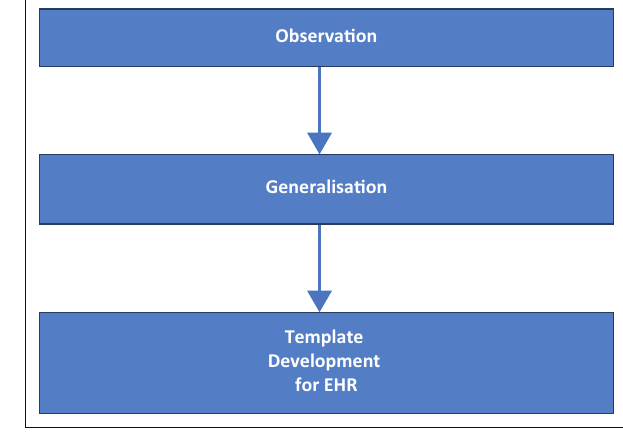
Observa(cid:24)on